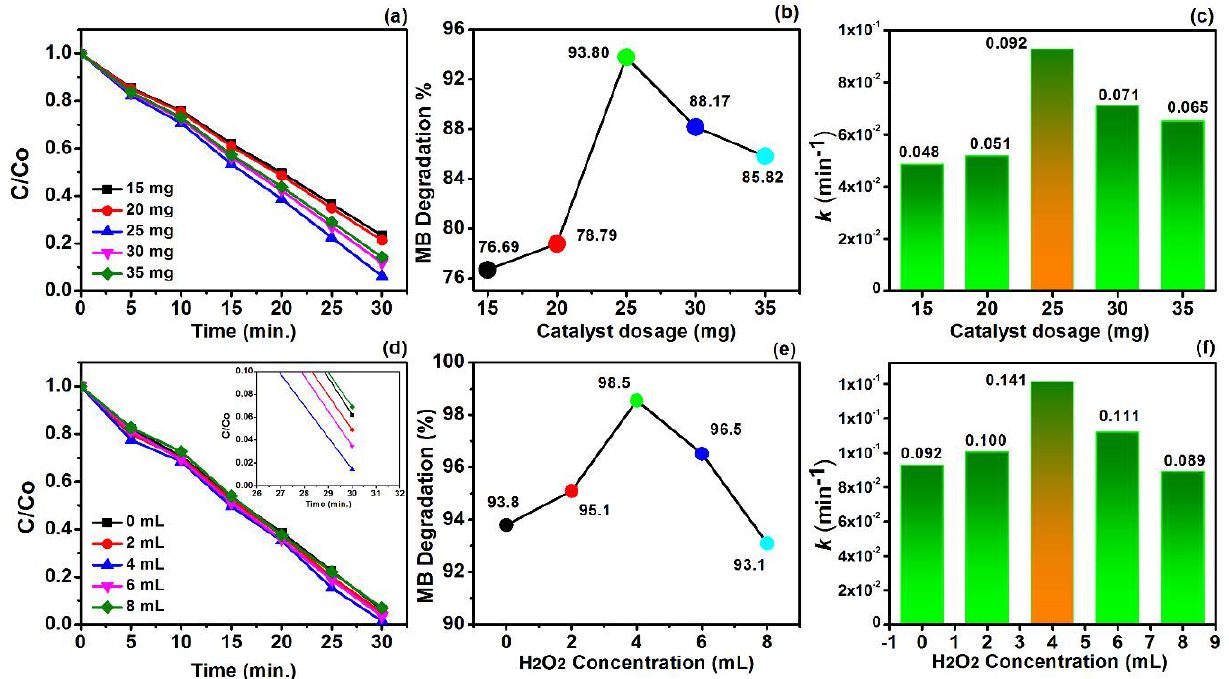
Figure 8. ( a – c ) Change in the reaction kinetics at different dosages of MoS 2 -Cu/CuO@GN, ( d – f ) change in the reaction kinetics at different dosages of hydrogen peroxide.